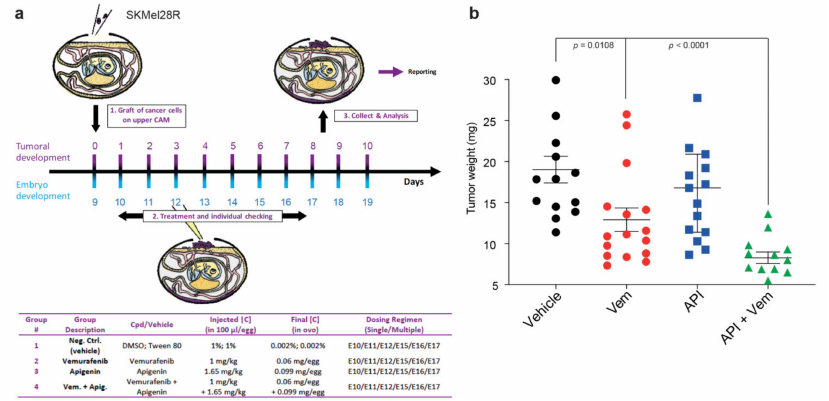
Figure 6. Apigenin increases tumor shrinkage of resistant melanoma cells treated with Vemurafenib. ( a ) Experimental protocol of grafting SKMel28R in the CAM (chick chorioallantoic membrane) of